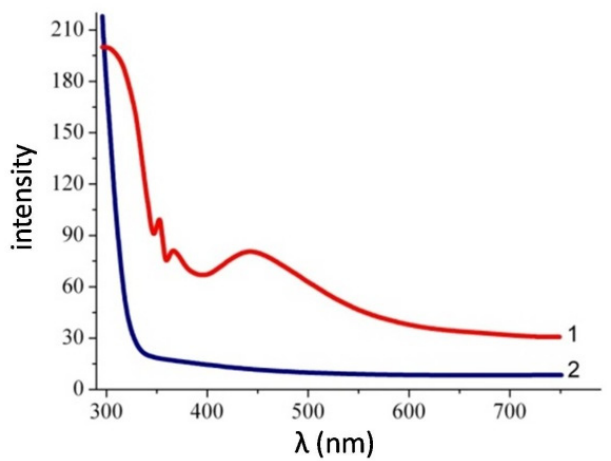
Figure 8. Absorption spectra of films containing 100 mg/m 2 silver nanoparticles of different mor- phologies on the TiO 2 surface: ( 1 ) TiO 2 /Ag/TiO 2 nanowires; ( 2 ) TiO 2 .